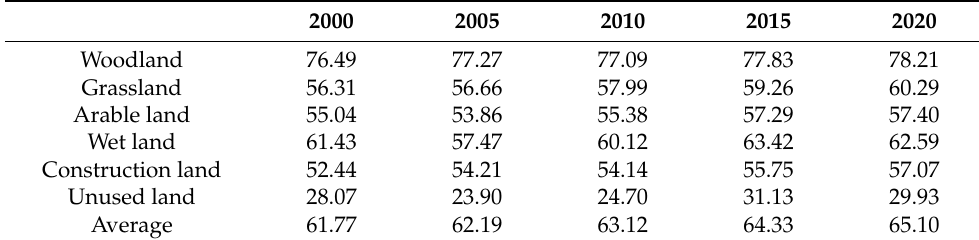
Table 12. EI index of each land type in Rangtang County from 2000 to